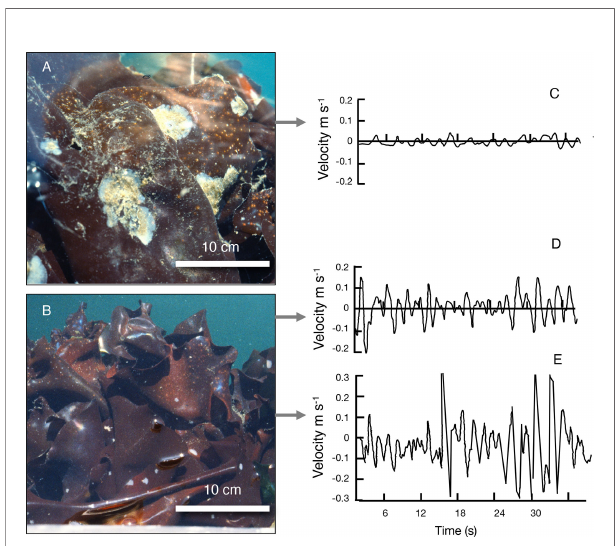
FIGURE 1 | Study sites on protected and exposed sides of the fl oating breakwater protecting the dock at Friday Harbor Laboratories (map of sites in Figure 2A ). (A) A canopy of M. splendens at the protected site, where white colonies of M. membranacea were living on the algal blades. (B) A canopy of M. splendens at the exposed site, where the algal blades were not covered with M. membranacea . For both (A, B) , the tire bumper on which the algae were growing is along the bottom of the picture (tire bumpers on the breakwater are shown in Figure 2B ). (C) Examples of water velocities recorded just upstream of M. splendens at the protected site, (D) at the exposed site, and (E) at the exposed site as the wake of a large ferry hit the dock. The fl ow oscillations in (C, D) were due to small waves (wind chop), and in (E) were due to larger waves in the ferry